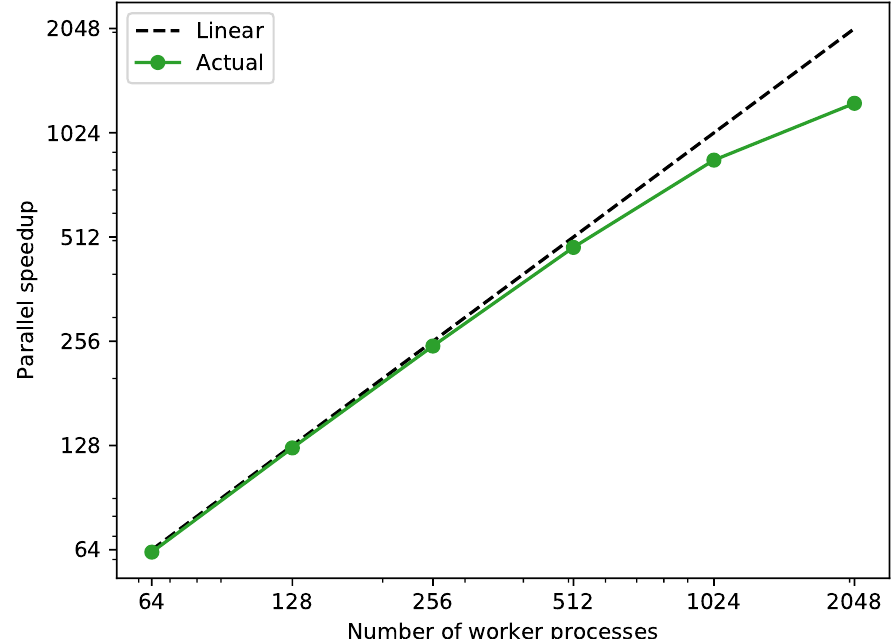
Figure 11. Parallel speedup against sequential simulation of the 10,000 scenarios generated in test case 4 with a different number of worker processes.